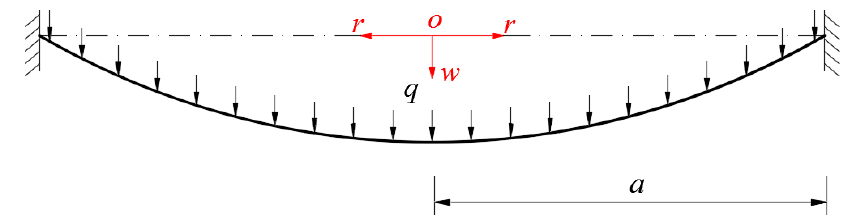
Figure 1. Sketch of the circular membrane under transverse loads q .